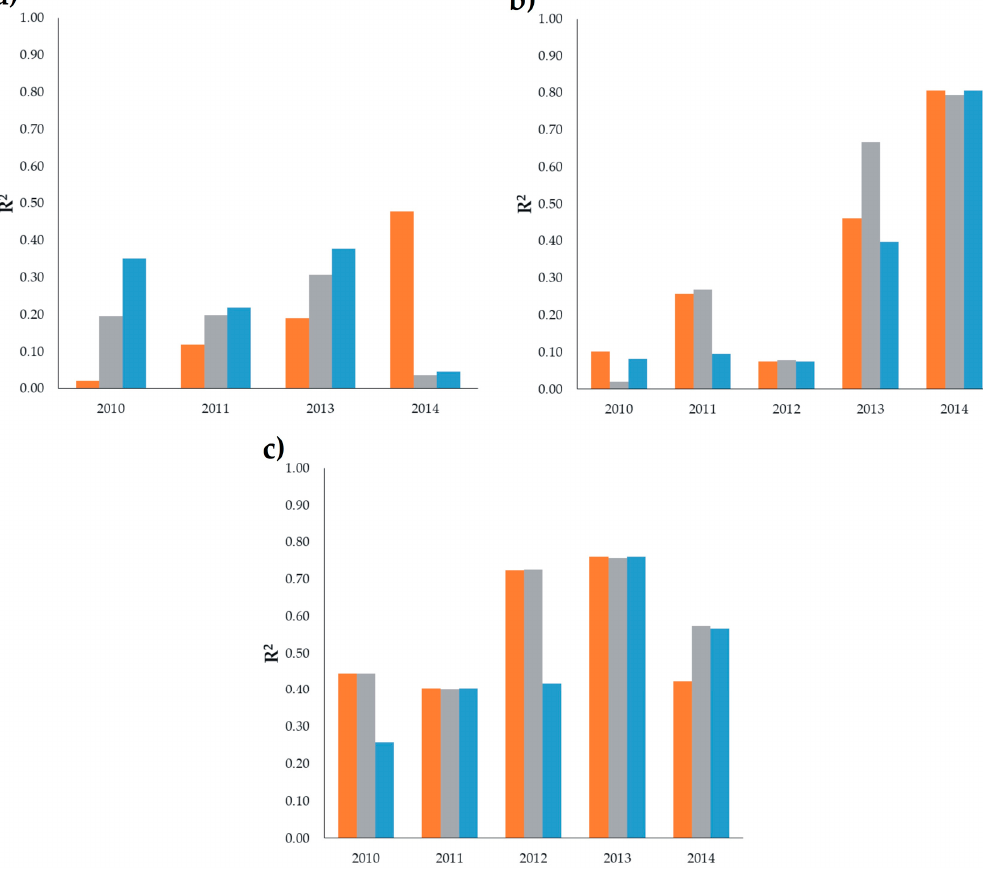
number of non-significant